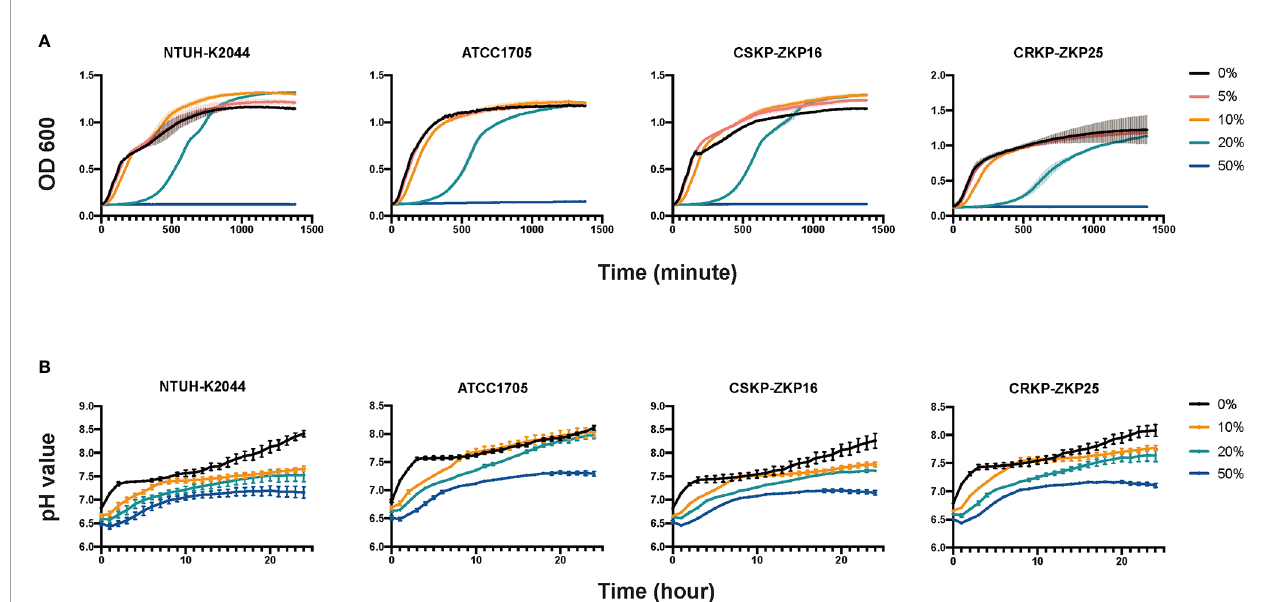
FIGURE 4 | K. pneumoniae growth curves and intracellular pH measurements. (A) Culturing K. pneumoniae in acetic acid-containing LB broth. LB with 50 mmol/L acetic acids (pH=3) is considered as modi fi ed LB that is combined with normal LB broth to achieve various concentrations of 5%, 10%, 20%, and 50%. (B) Intracellular pH values of K. pneumoniae . The aforementioned modi fi ed LB broth was combined with normal LB at 10%, 20%, and 50%